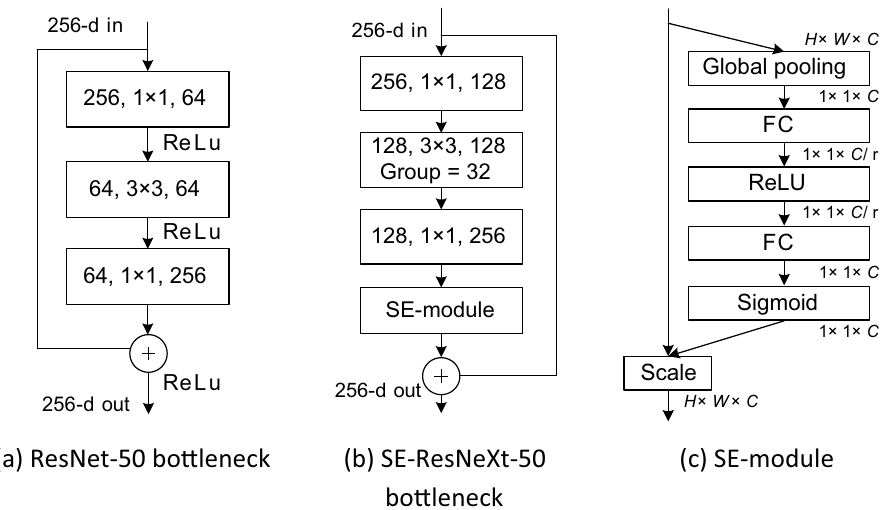
Figure 2. ResNet-50 and SE-ResNeXt-50 bottleneck blocks.